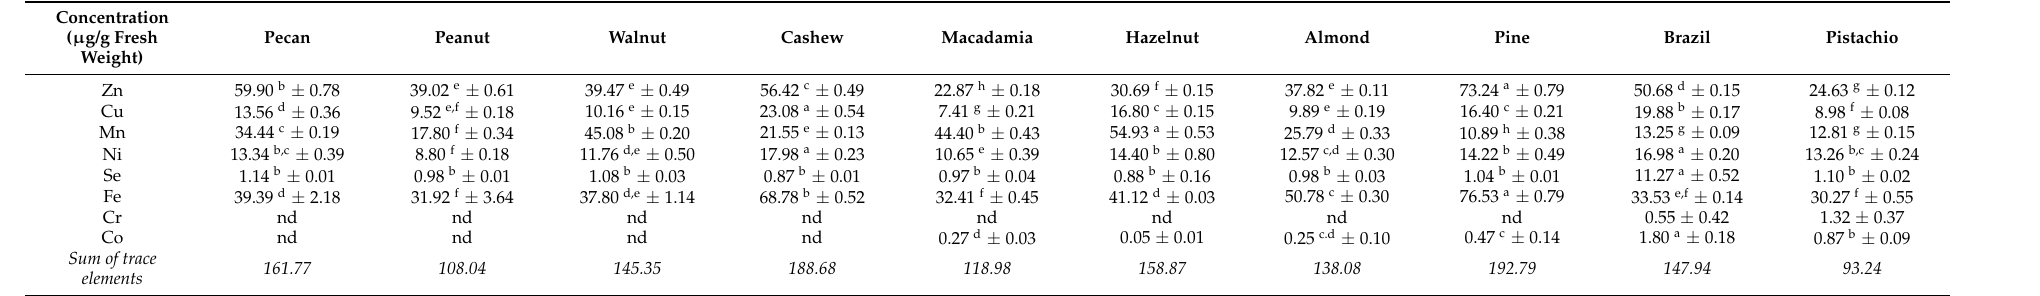
Table 4. The content of trace elements in